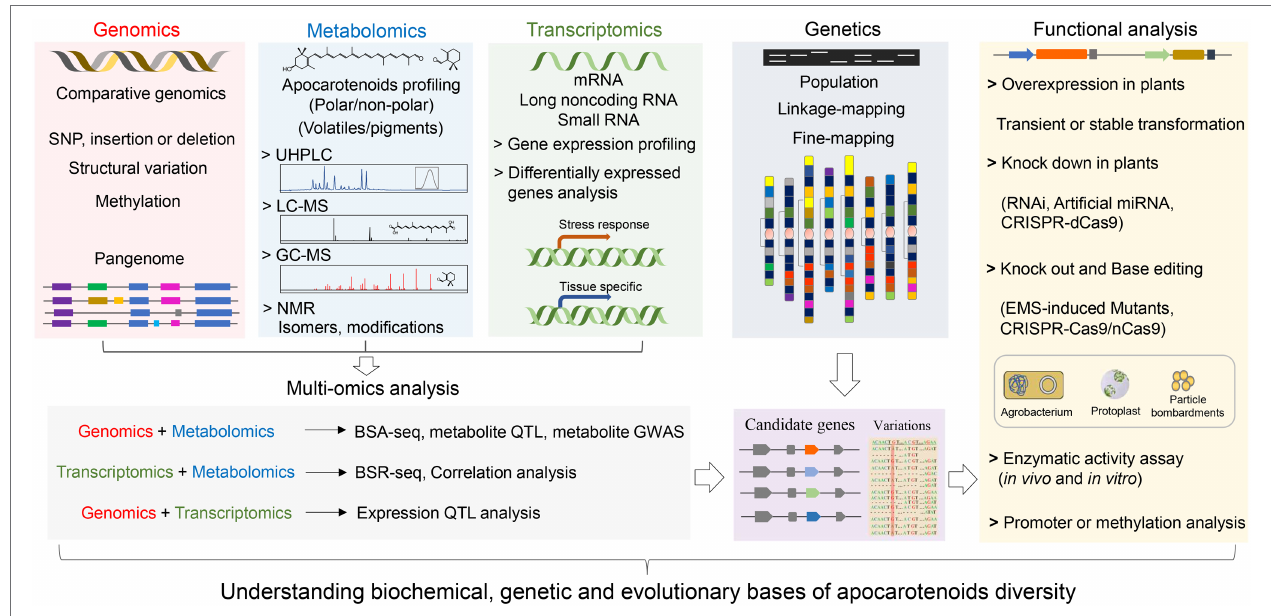
FIGURE 4 | A schematic workflow for multi-omics strategy coupled with genetic and functional analysis to elucidate the molecular mechanisms underlying apocarotenoid variation. The multi-omics strategy combines genomics, transcriptomics, and metabolomics approaches. Functional analysis includes overexpression, knockdown, and knockout of candidate genes, which can be performed by using Agrobacterium-, protoplast-, or particle bombardments-mediated transformation strategies. For structural genes, such as CCD genes, evaluation of the activity of encoded enzymes ( in vivo and in vitro ) can be performed to confirm the functional variation. Promoter and methylation analysis are usually conducted to explore genetic bases underlying expression variation of candidate genes. GWAS, genome-wide association study; QTL, quantitative trait locus; eQTL, expression QTL; and mQTL, metabolites QTL. BSA-Seq, bulked-segregant analysis (BSA) coupled to whole-genome sequencing. BSR-Seq, BSA coupled to RNA-seq